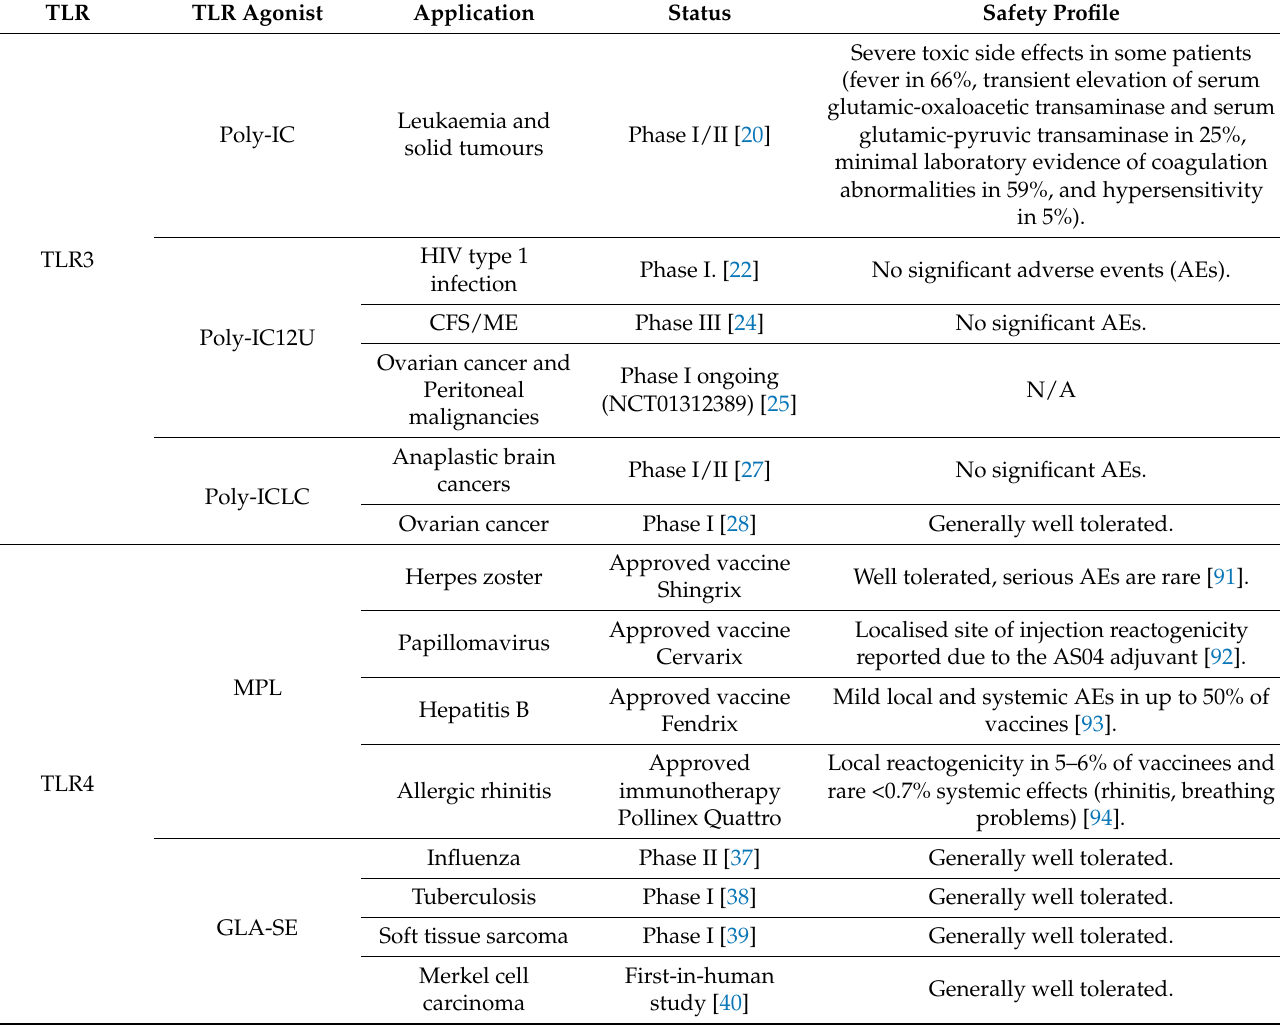
Table 1. Application, clinical trial or approval status, and safety profile of clinically used TLR agonists. TLR TLR Agonist